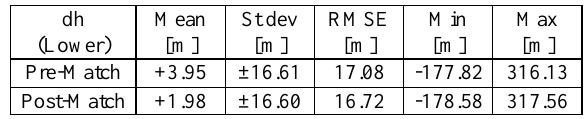
Table 3. Statistics of elevation differences over stable terrain at